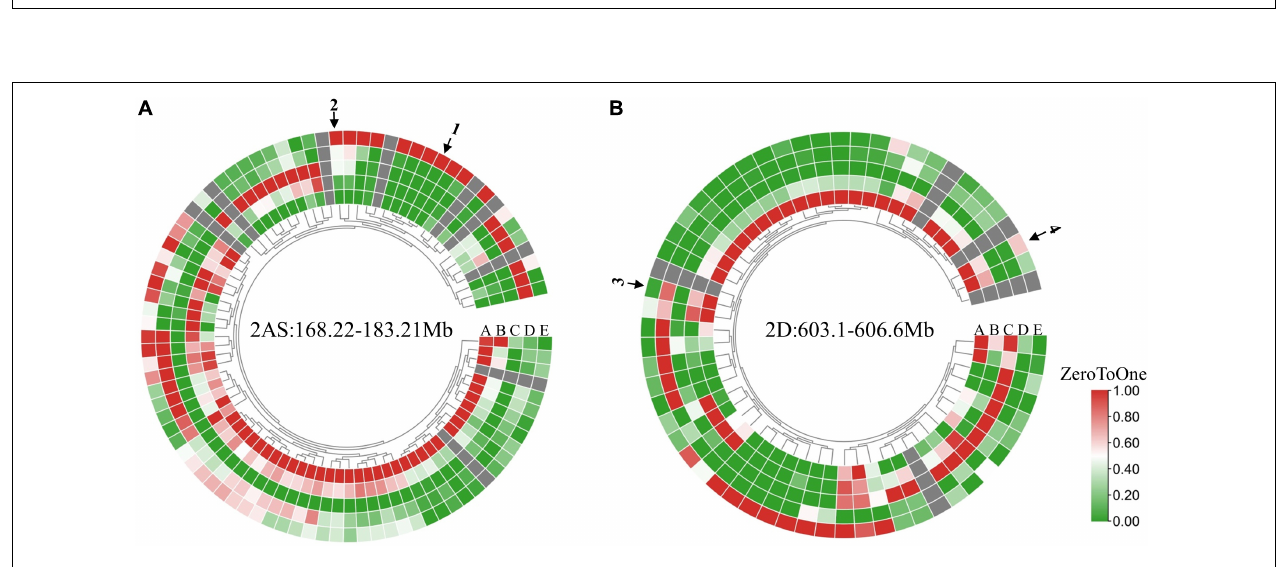
FIGURE 7 | Effects of QSc/Sl.cib-2AS (A), QSc/Sl.cib-2AL (B), and QSc/Sl.cib-2D (C) on plant height (PHT), productive tiller number (PTN), spikelet number per spike (SNS), grain number per spike (GNS), thousand grain weight (TGW), GL/GW (GLW) ratio, grain length (GL), grain width (GW), and grain roundness (GR) in the BC20 population. BLM and CY20 represent lines with the alleles from BLM and CY20, respectively. *, **, and *** represent significance at P < 0.05, P < 0.01, and P < 0.001, respectively.